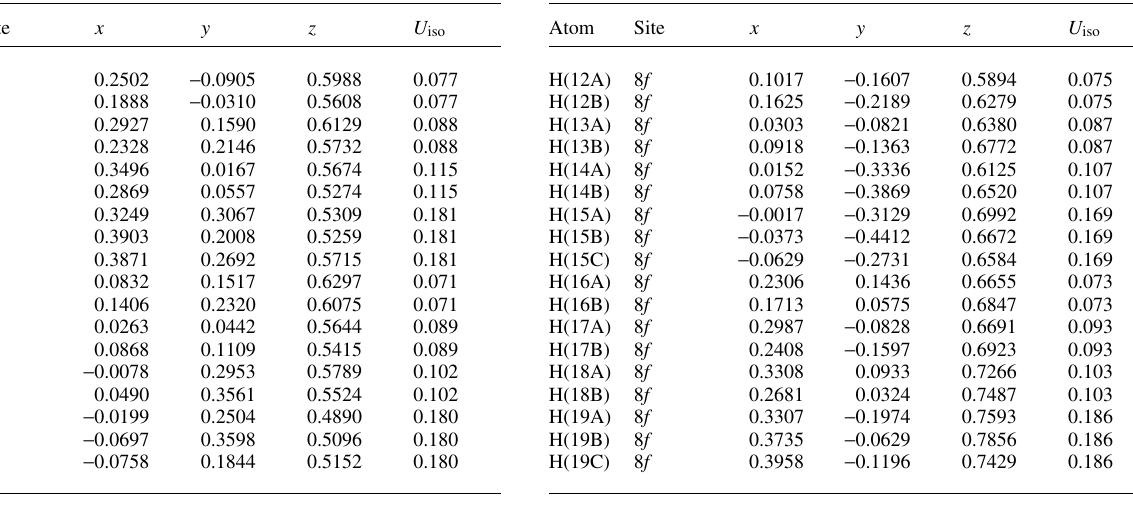
Table 2. Atomic coordinates and displacement parameters (in Å 2 )